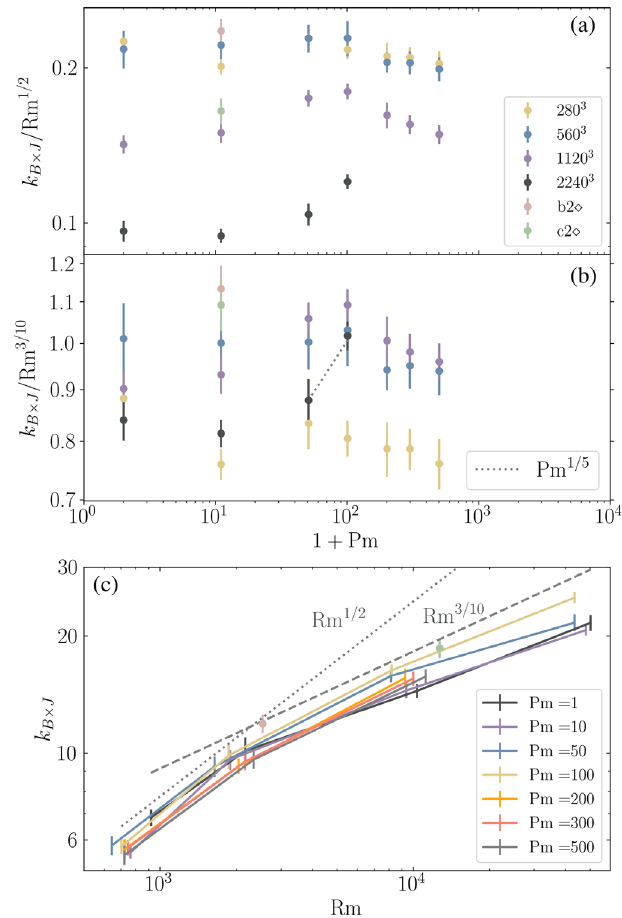
FIG. 8. Dependence of the field-reversal wave number k B on × J plasma parameters in the saturated state. (a),(b) k B vs Pm at × J different Rm; the color coding is the same for these two panels. In (a), k B is divided by Rm 1 = 2 , the predicted Rm dependence of × J the inverse resistive scale l − 1 η ; in (b), k B is divided by Rm 3 = 10 , × J [see the predicted Rm dependence of the inverse tearing scale λ − 1 (cid:2) Eq. (10)]. (c) k B vs Rm at different Pm. Low-Rm runs show an × J ∼ 2 π = l Rm dependence consistent with the resistive scale k B η ; × J high-Rm runs show an Rm and Pm dependence consistent with ∼ 2 π = λ the predicted tearing scale k B × J (cid:2)